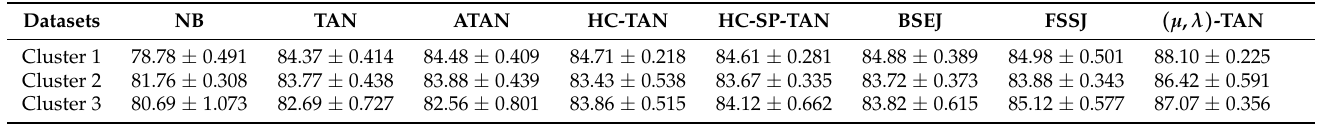
Table 5. Performance comparison of NB, TAN, ATAN, HC-TAN, HC-SP-TAN, BSEJ, FSSJ, and ( µ , λ ) -TAN in terms of F 1 -score in the test